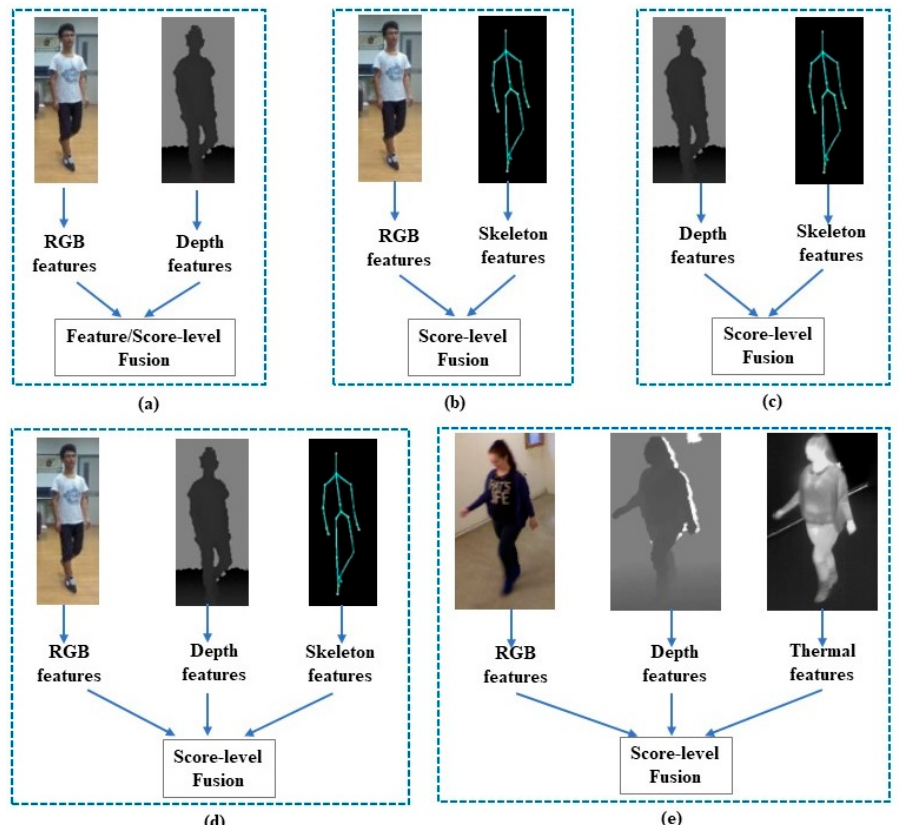
Figure 4. Different multi-modal person re-identification approaches (feature/score-level fusion), where each approach uses different modalities. ( a ) RGB and depth modalities; ( b ) RGB and skeleton information; ( c ) depth and skeleton information; ( d ) RGB, depth, and skeleton information; and ( e ) RGB, depth, and thermal images [44].